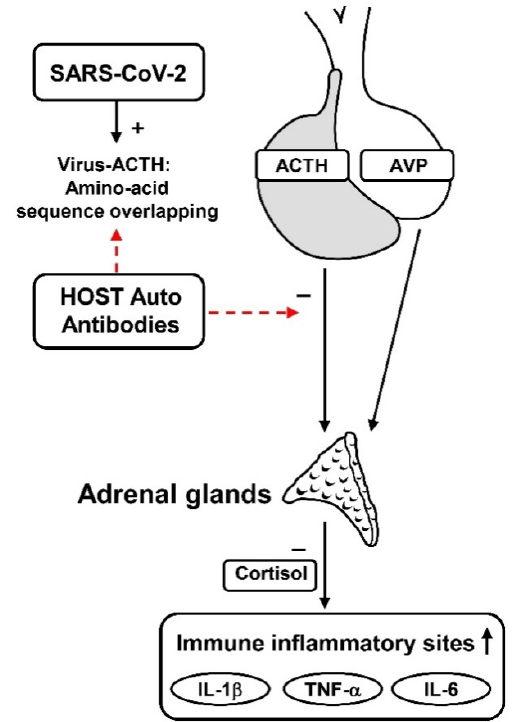
Figure 1. Possible strategy by which SARS-CoV-2 may deflect the host’s immune response. The amino-acid sequence, which the virus shares with the ACTH, induces the production of autoantibodies against this pituitary hormone that prevents the suitable adrenal response to the stress. ACTH: adrenocorticotropic hormone; AVP: arginine-vasopressin; IL-1 β : interleukin 1 beta; IL-6: interlukin